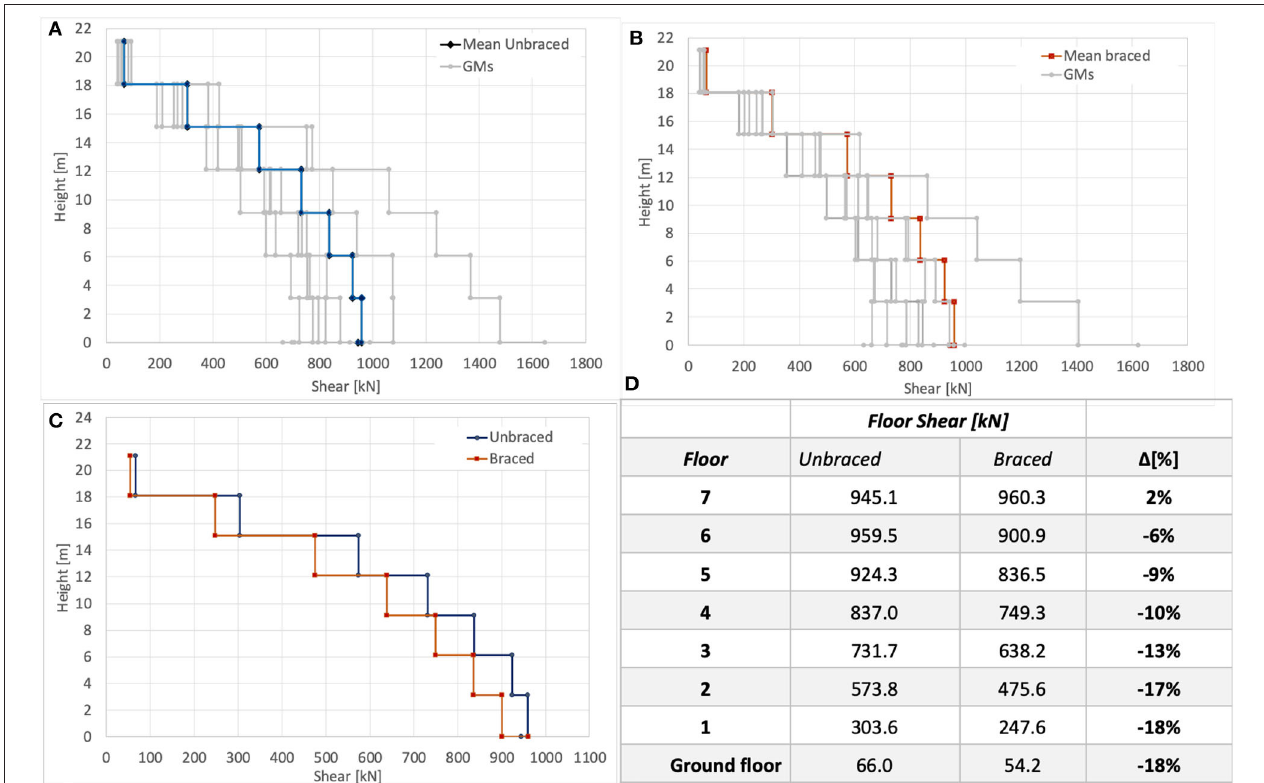
FIGURE 12 | NLD analyses results. (A) Maximum floor shears in Y-direction for the unbraced system. (B) Maximum floor shears in Y-direction for the braced system. (C) Comparison of average values of maximum floor shears between braced and unbraced systems. (D) Comparison of the average values of the maximum floor